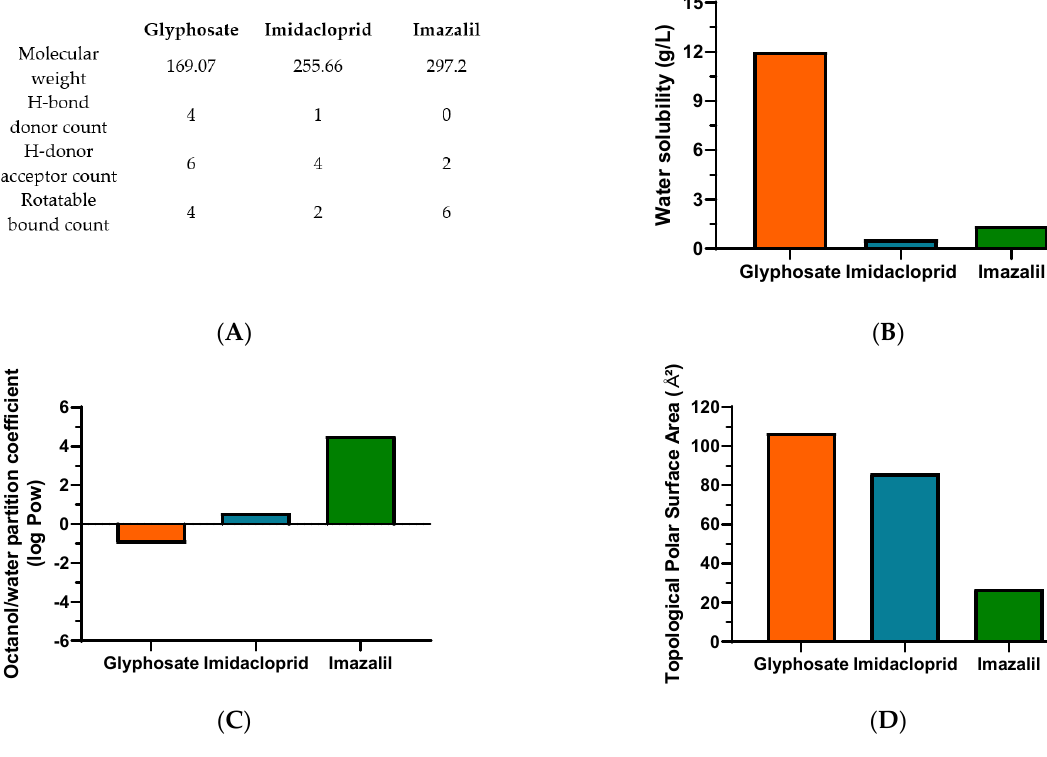
Figure 4. Physicochemical properties of glyphosate, imidacloprid and imazalil relevant to their toxicity to human cell line models. Pesticides’ molecular weight and relevant chemical bonds information ( A ), water solubility ( B ), octanol/water partition coefficient ( C ) and topological surface area ( D ). Data was obtained from Pubchem and INCHEM (IPCS, World Health Organization) [49–52].